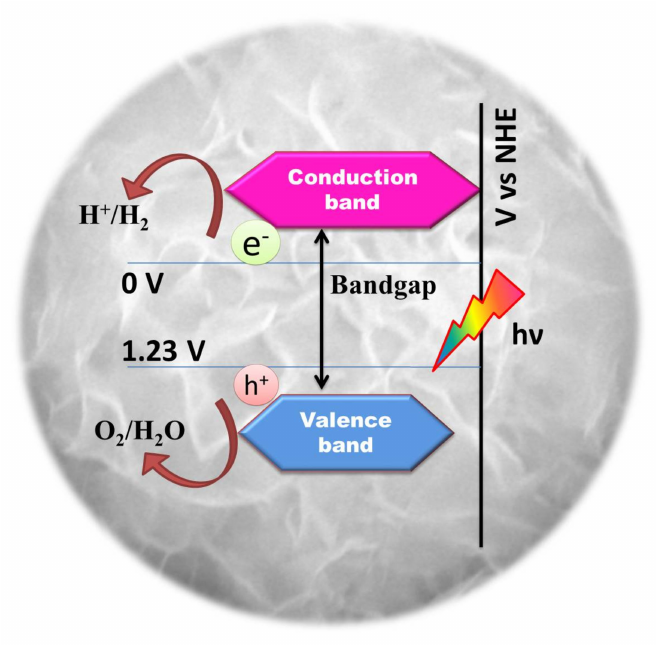
Figure 2. Schematic illustration of the essential electronic structure of a photocatalyst for water